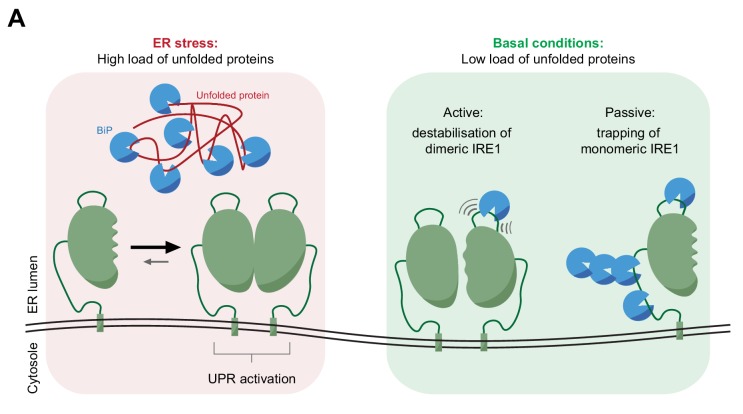
Cartoon depicting features of BiP-mediated regulation of IRE1 activity.In stressed cells unfolded proteins compete for BiP, exposing IRE1LD to a default dimeric active state, specified by the kinetics of the monomer-dimer equilibrium (left panel). In compensated cells BiP (assisted by ERdj4 and possibly other J-domain proteins, not shown) binds flexible regions of IRE1LD. Engagement of these regions in the IRE1LD dimer may favor active dimer disassembly by entropic pulling or allosterically induced conformational changes (right panel). BiP binding to the same flexible regions of the IRE1LD monomer, may inactivate IRE1 by disfavoring re-dimerisation (right panel). The dynamic nature of BiP binding, which entails cycles for ATP hydrolysis-driven client engagement and nucleotide exchange-mediated release, ensures that IRE1 activity is kinetically coupled to the balance between unfolded protein load and folding capacity of the cell.